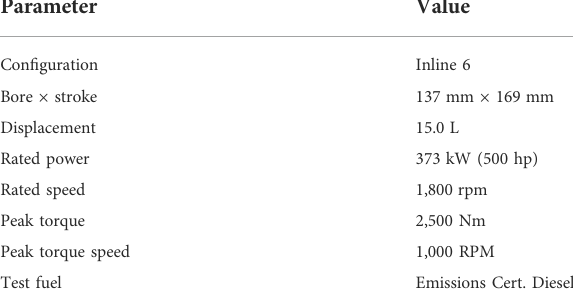
TABLE 1 Cummins X15 engine parameters.